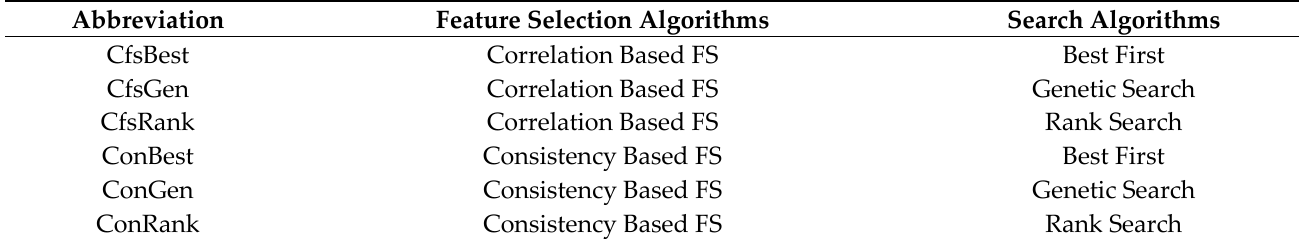
Table 8. Used Feature Selection and Search Algorithms.